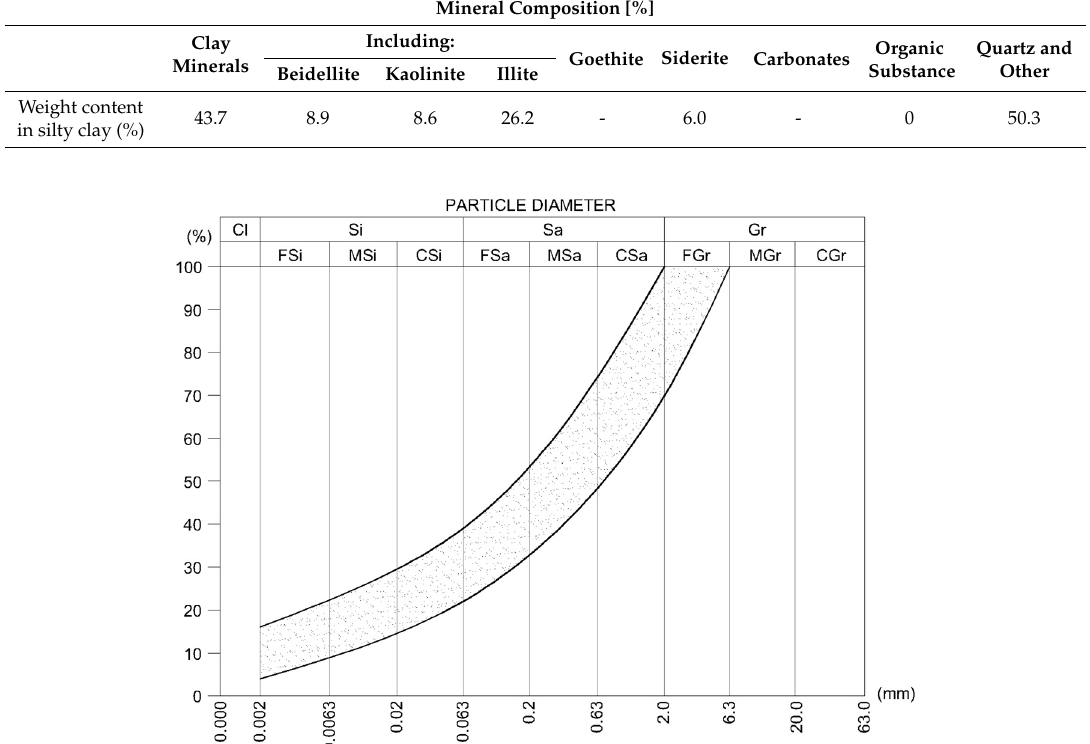
Figure 2. The grain size range of soils mixes used for samples preparation.